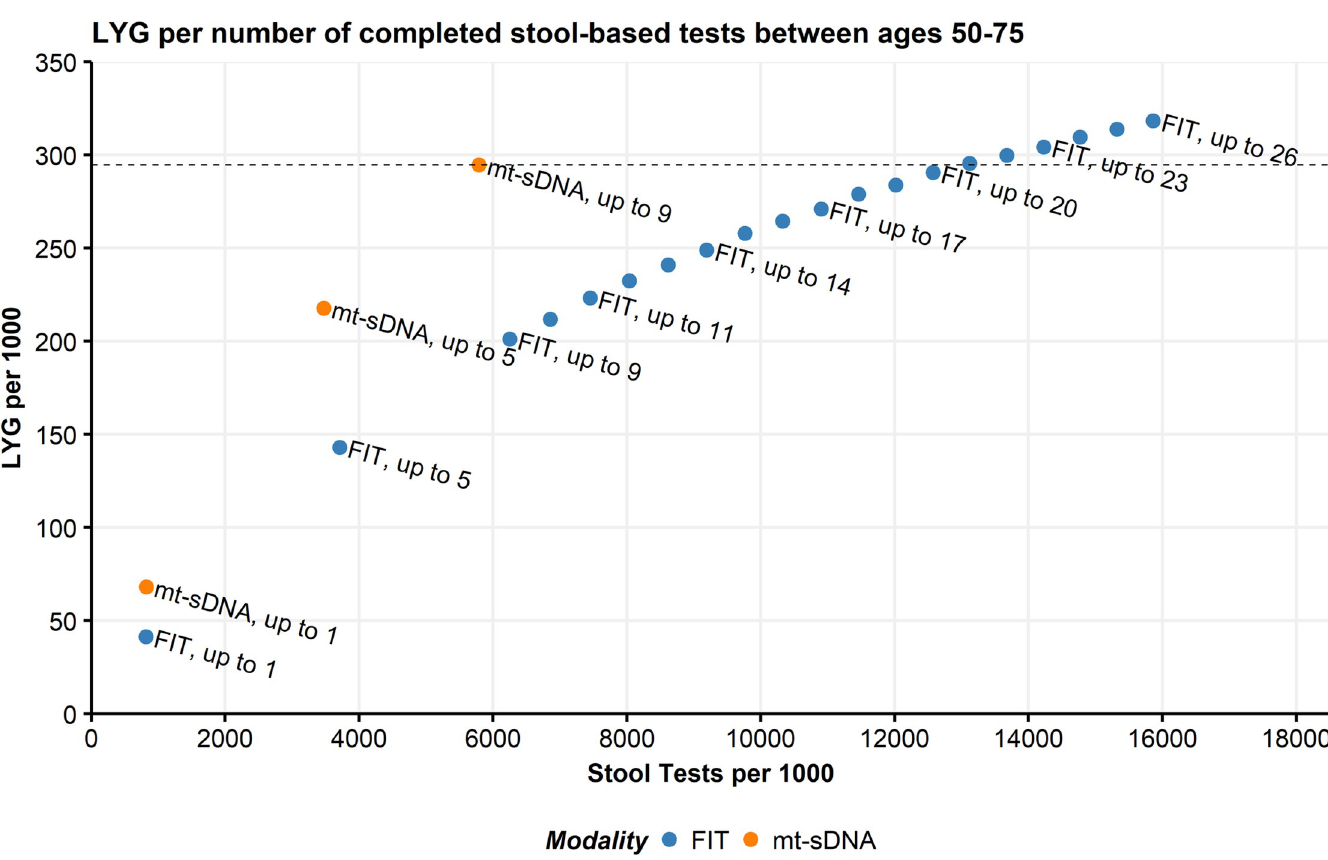
Fig 4. Predicted Life-Years Gained (LYG) by total stool tests per 1000 individuals screened from ages 50–75 compared with no screening. Individuals were randomly assigned numbers of multitarget stool DNA (mt-sDNA; max = 9 triennial tests during the screening window) or fecal immunochemical tests (FIT; max = 26 annual tests during the screening window). The line indicates equivalent LYG with up to 9 mt-sDNA